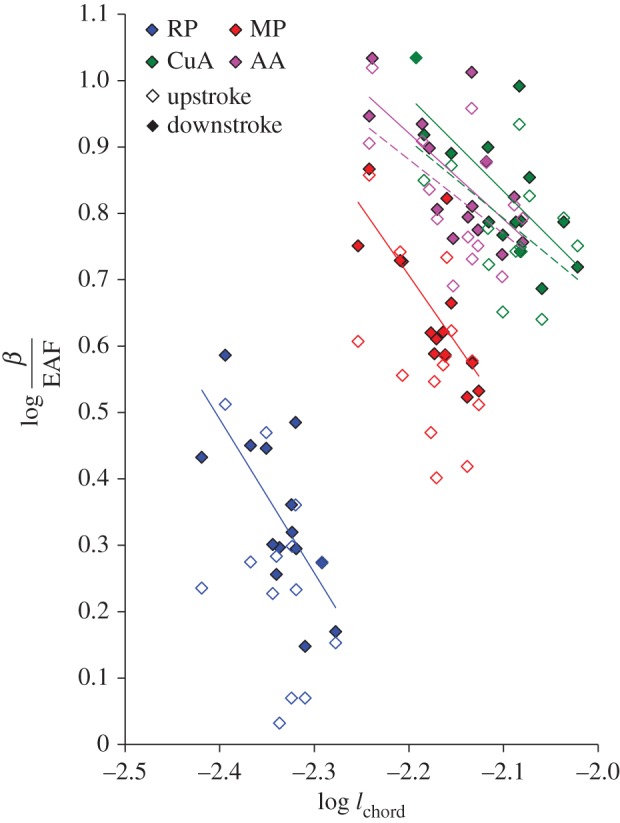
Logarithmic relationship between force-specific deflection (β/EAF) of landmarks and chord length (lchord). Full and open rhombi denote deflections during mid-downstroke and mid-upstroke, respectively. Colours and landmark names are as in figure 1a. Statistically significant linear regressions (on log-transformed data) are denoted by a trend line; see electronic supplementary material, S9 for elaborated statistics.